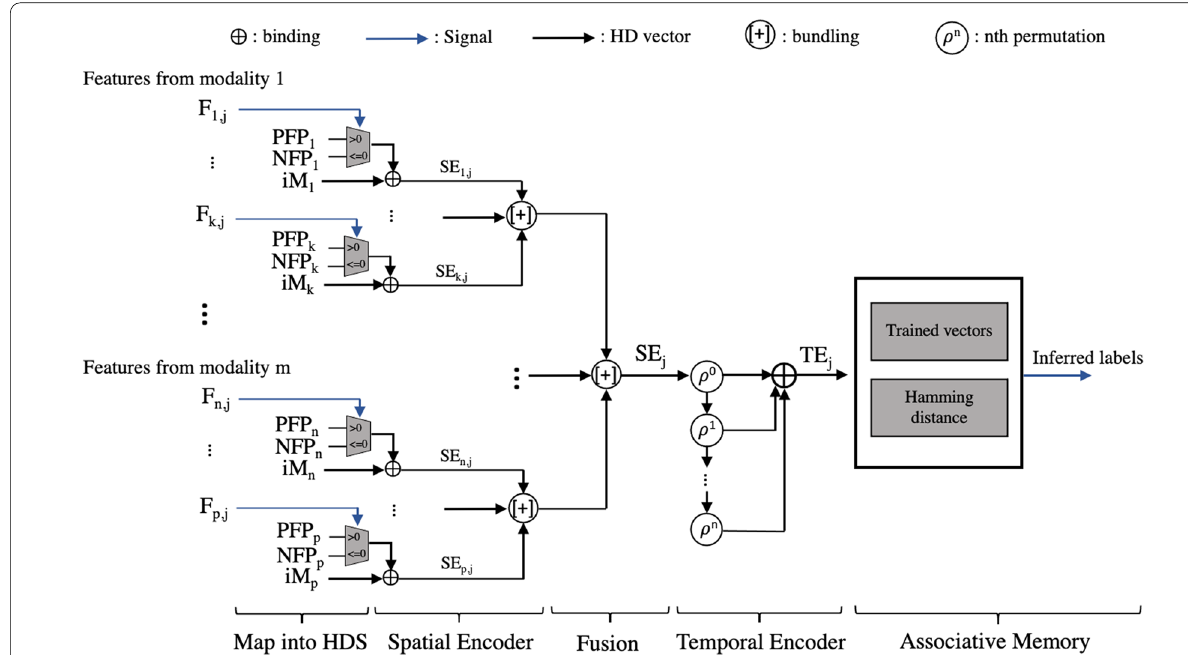
Fig. 2 HDC early fusion detailed architecture for m modalities with the four main blocks: map into HDS, spatial encoder, temporal encoder for n-gram of size n 1, and associative memory. Sensor fusion occurs early in the datapath, directly after the spatial +